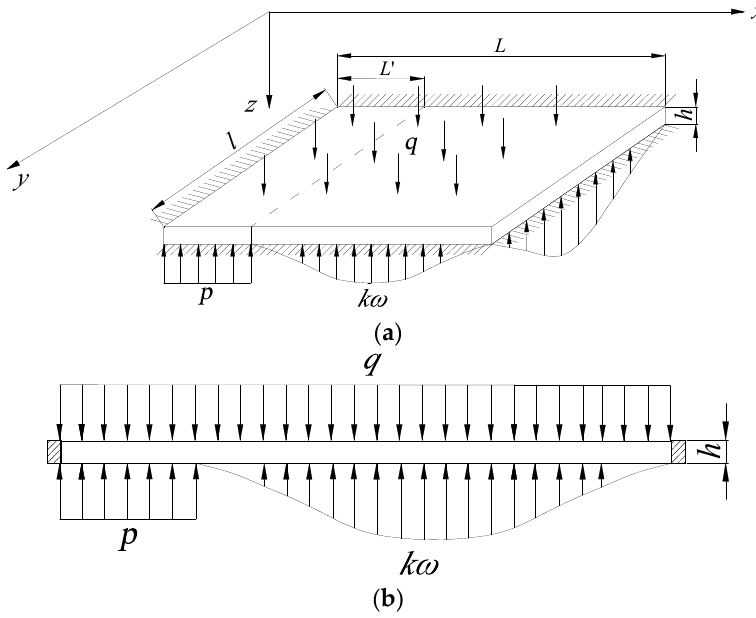
Figure 3. Elastic-thin-plate mechanical model of main roof in CMCB. ( a ) 3-D view of model; ( b ) Section view of model.